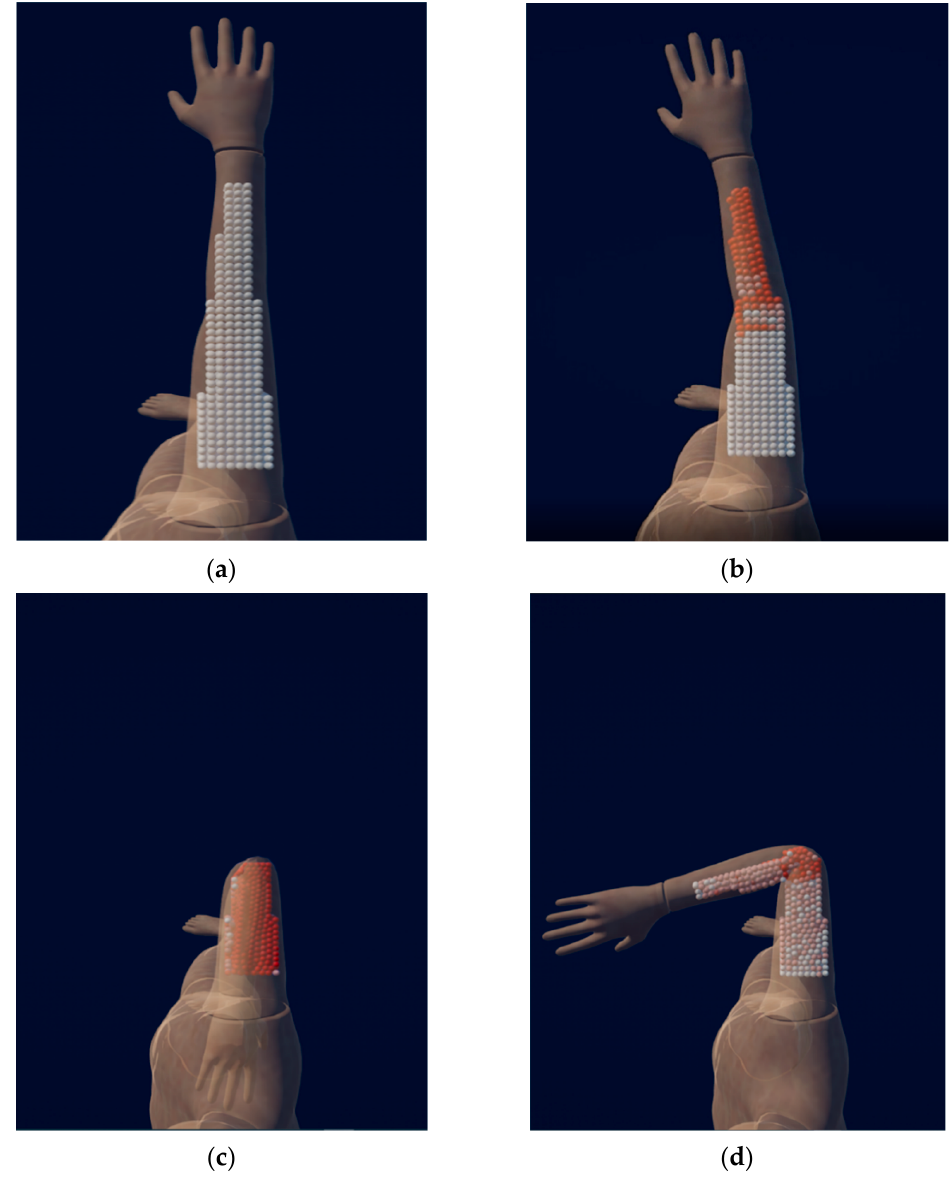
Figure 4. Elastic simulation showing the limit of deformation by the proposed yield condition: ( a ) initial state; ( b ) starting to receive external force from the upper right; ( c ) receiving external force from the upper right without applying the proposed yield condition; ( d ) receiving external force from the upper right with the proposed yield condition.